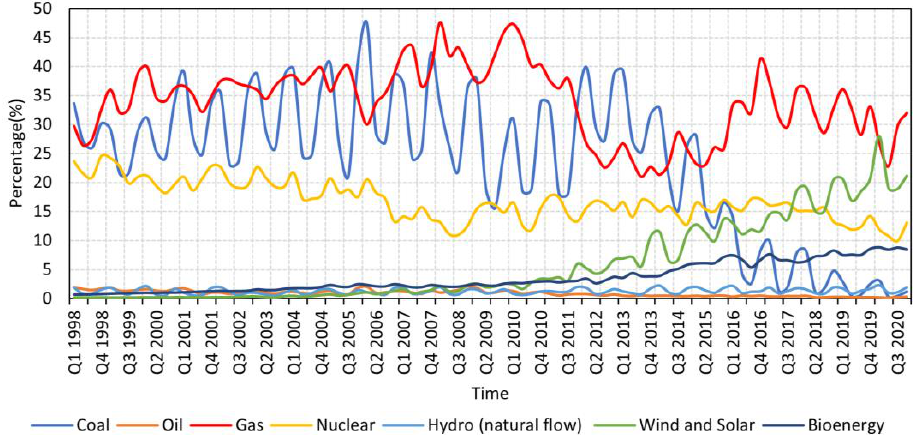
Figure 1. The percentage of different sources in terms of electricity generation from 1998 to 2020.